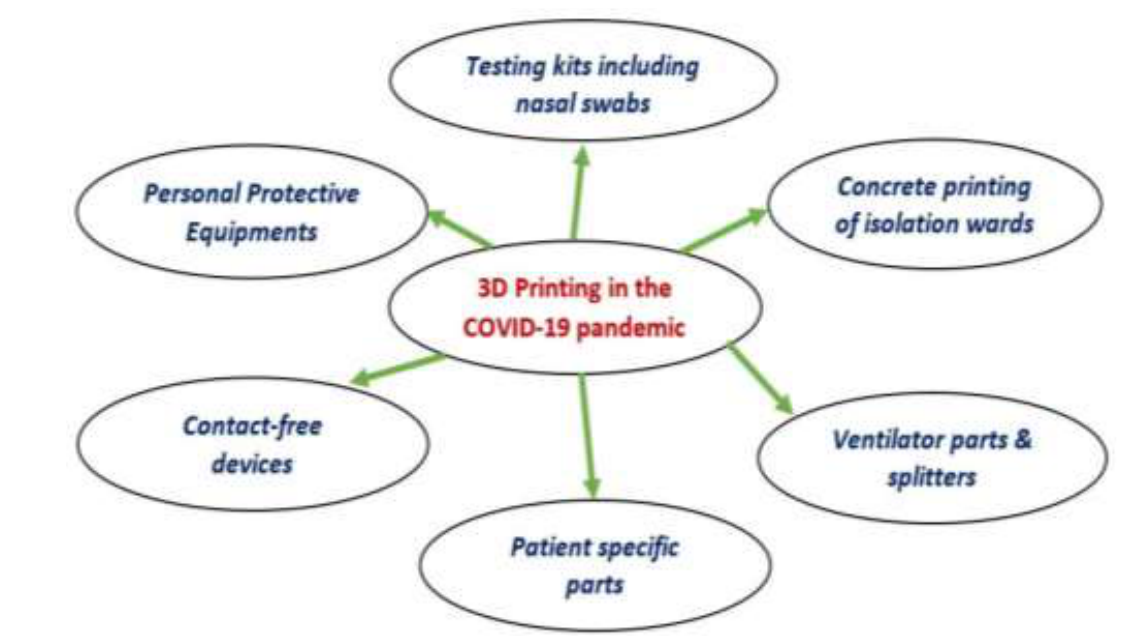
Figure 2. Wide range of applications of 3D printing during the COVID-19 pandemic.